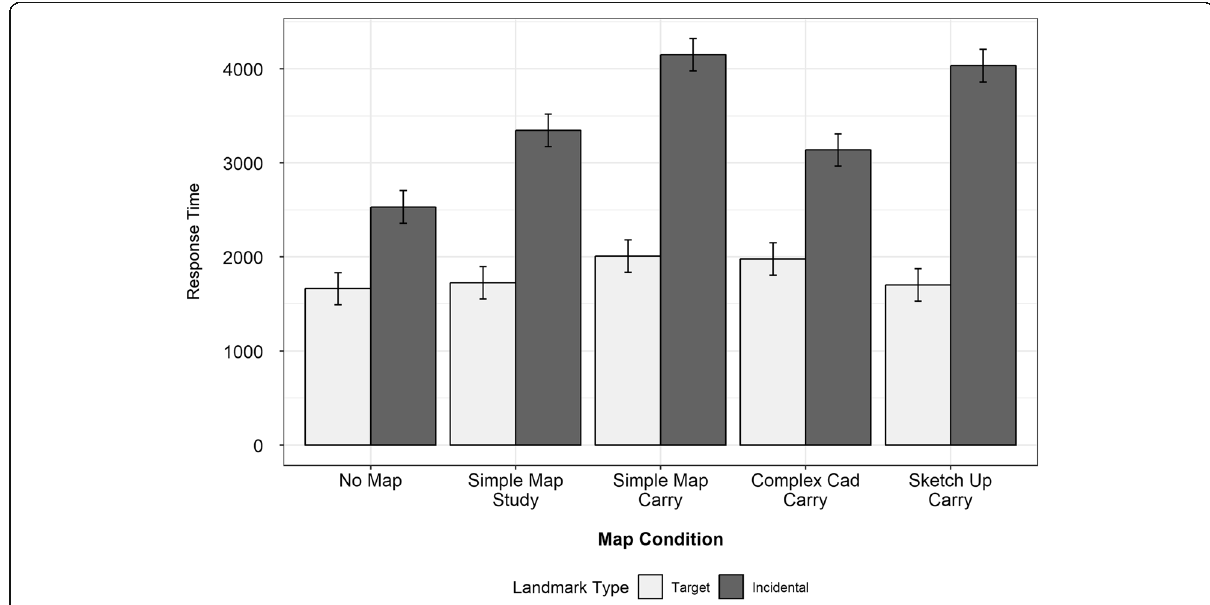
Fig. 10 Response times for correct responses to landmark recognition test trials, split by landmark type and map